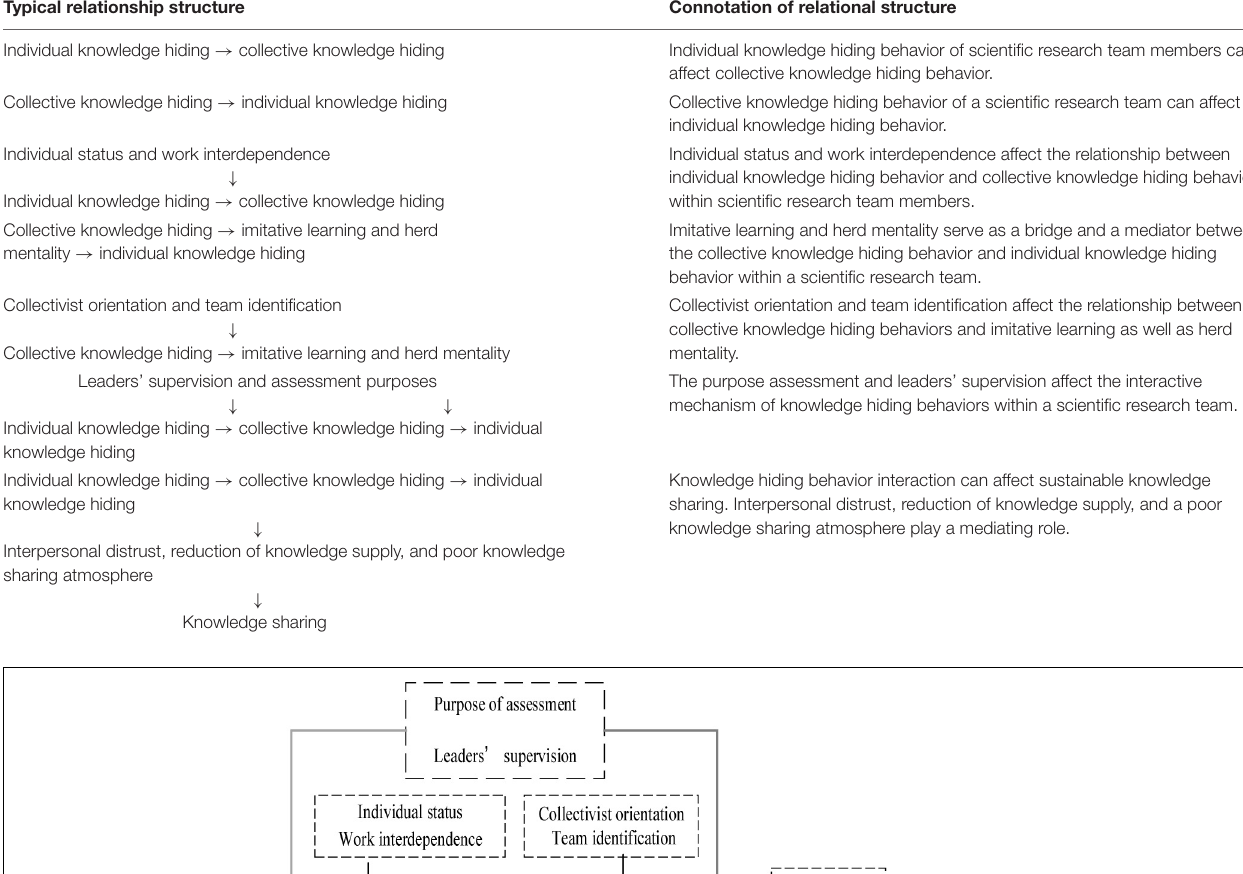
TABLE 4 | Results of selective coding.